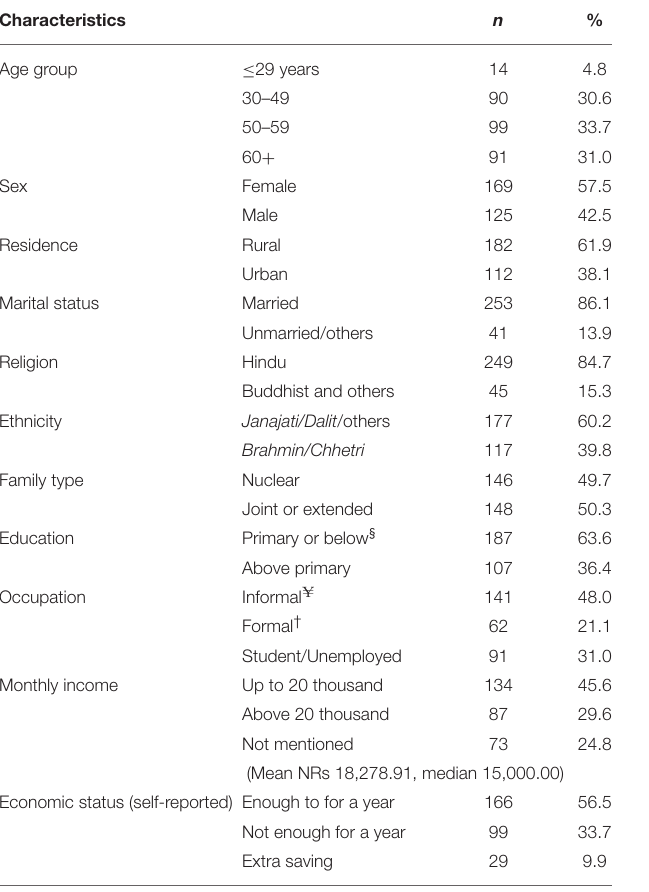
TABLE 1 | Socio-demographic characteristics of participants ( n = 294). Characteristics